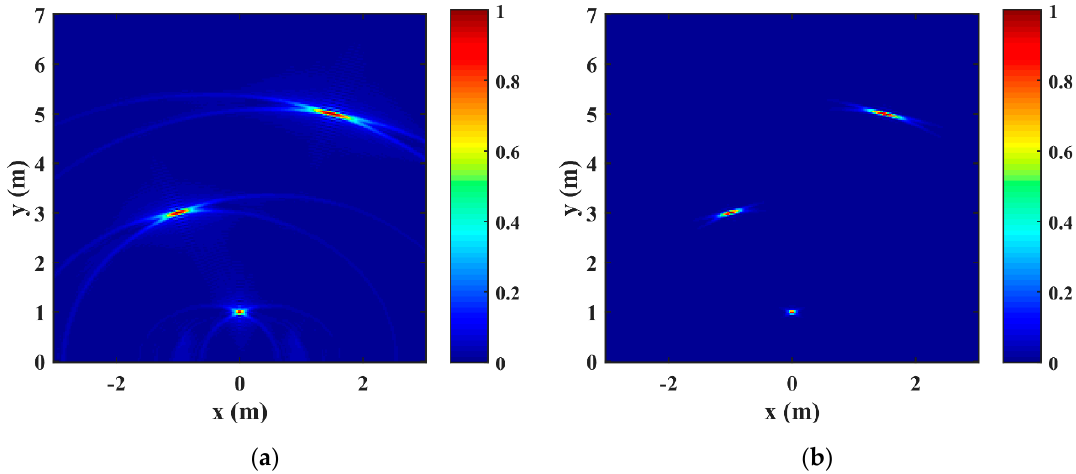
Figure 6. Simulations for the MIMO sparse array by: ( a ) the time domain back projection (TDBP) algorithm; ( b ) the cross-correlation-based time domain back projection (CC-TDBP) algorithm.